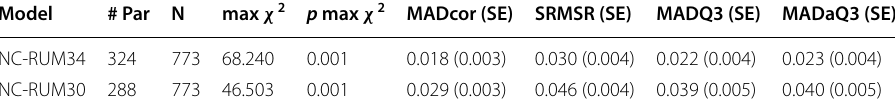
NC-RUM30/34 Non-compensatory reparameterized unified model with 30/34 tasks. χ 2 Chi-square, p significance, MADcor Average absolute deviation between observed correlations and model predicted correlations, SRMR Standardized root mean square root of squared residuals, MADQ3 Mean of absolute values of Q3 statistic (Yen 1984), MADaQ3 Mean of absolute values of centered Q3 statistic, SE Standard errors